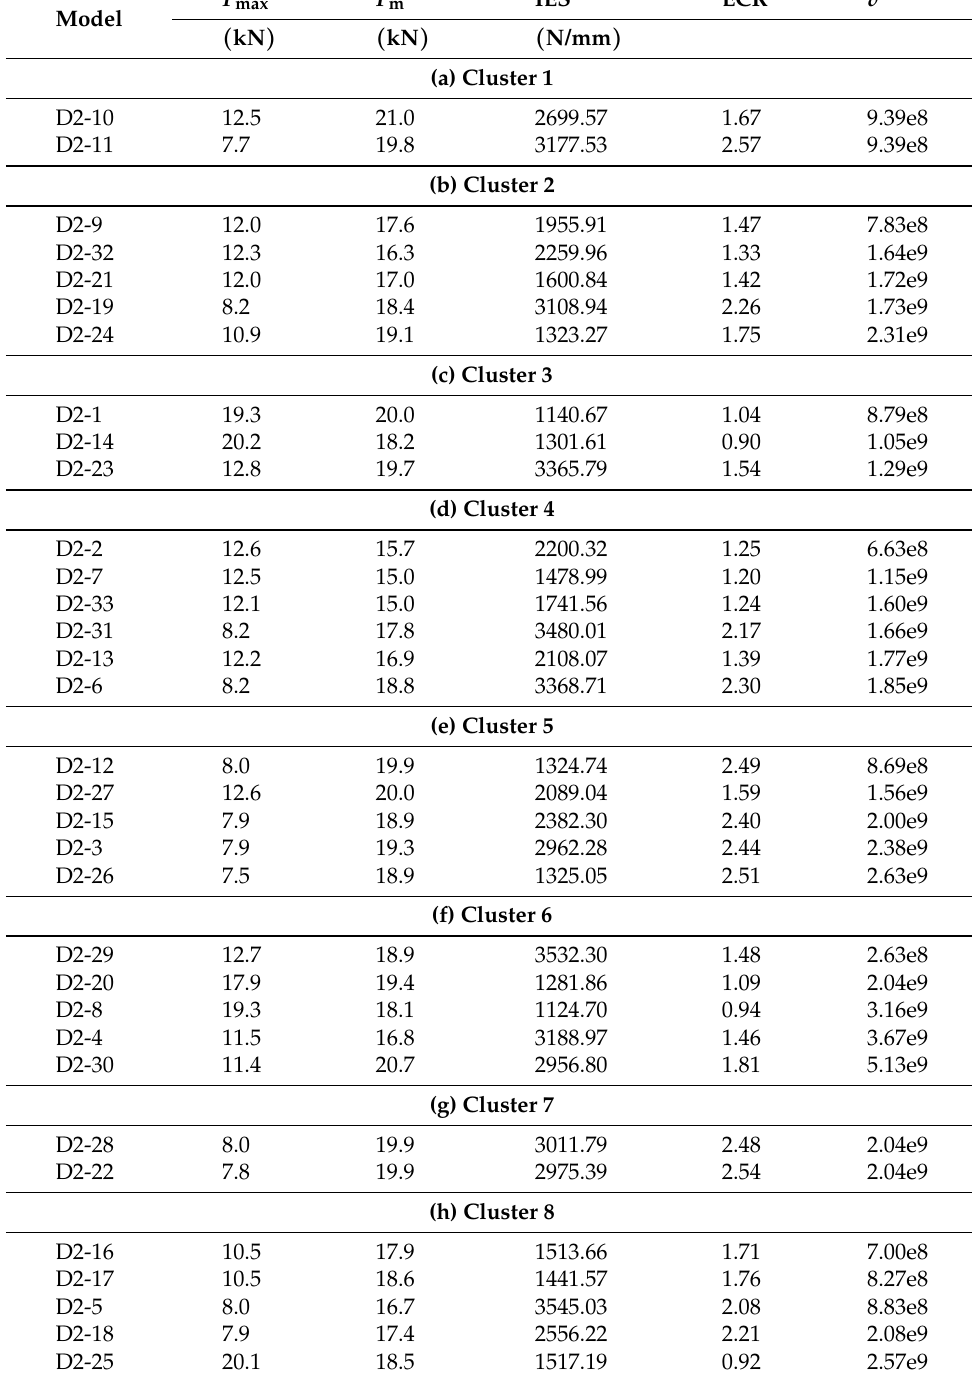
Table 2. Numerical results in each